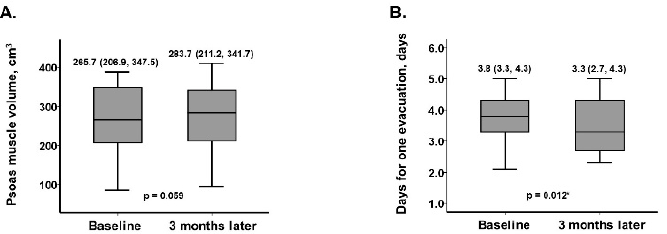
Trends in other laboratory data are displayed in Table 2. Serum albumin and lymphocyte count increased significantly (p = 0.025 and p = 0.040, respectively). Other variables re- 137 mained unchanged (p >0.05 for all).